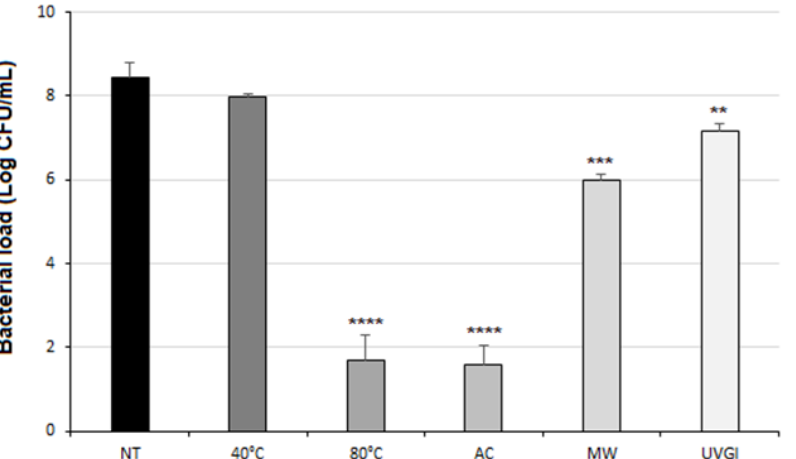
Figure 2. Bacterial load on soiled masks after one cycle of each decontamination method. Bacterial load (Log CFU/mL) on soiled masks after one cycle of each decontamination method. Not treated (NT); immersion in hot water at 40 °C (40 °C); immersion in hot water at 80 °C (80 °C); to autoclave steam (AC); microwave-assisted sterilization (MW) and exposure to UVGI (UVGI). Results are reported as mean ± SD of two independent experiments) (**, p < 0.01; ***, p < 0.001; ****, p < 0.0001) .